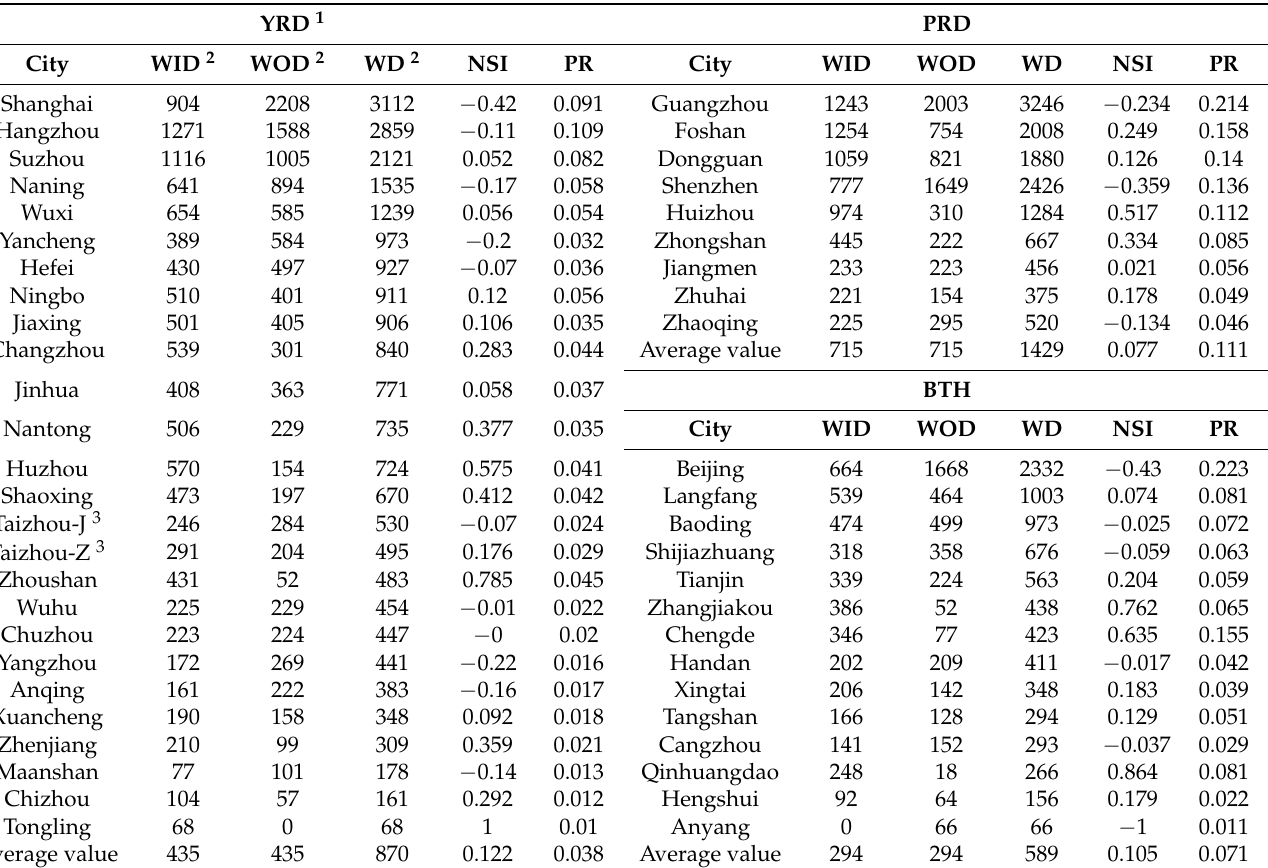
Table 5. Node attributes of check-in network of three major urban